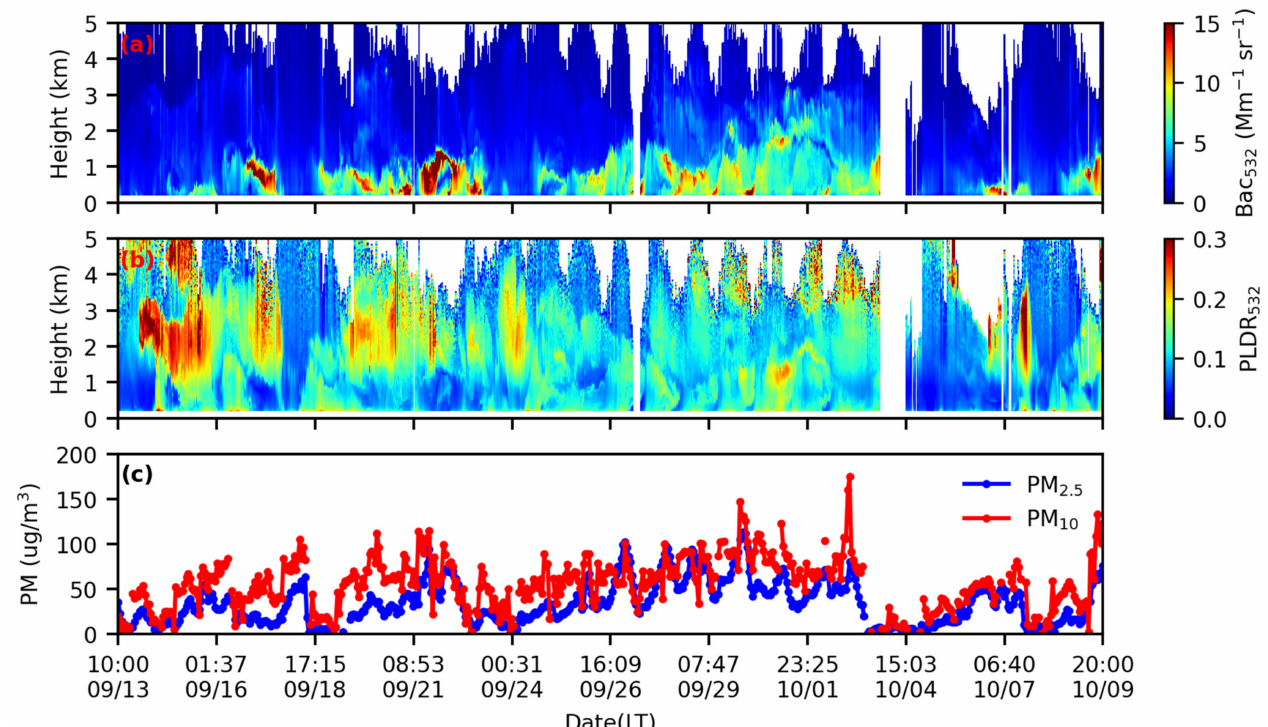
Figure 2. Period air pollution cycles in Beijing from 13 September to 9 October 2019. Time–height plots of the ( a ) Bac 532 and ( b ) PLDR 532 are measured by PRL. ( c ) Time series of surface PM 2 . 5 and PM 10 mass